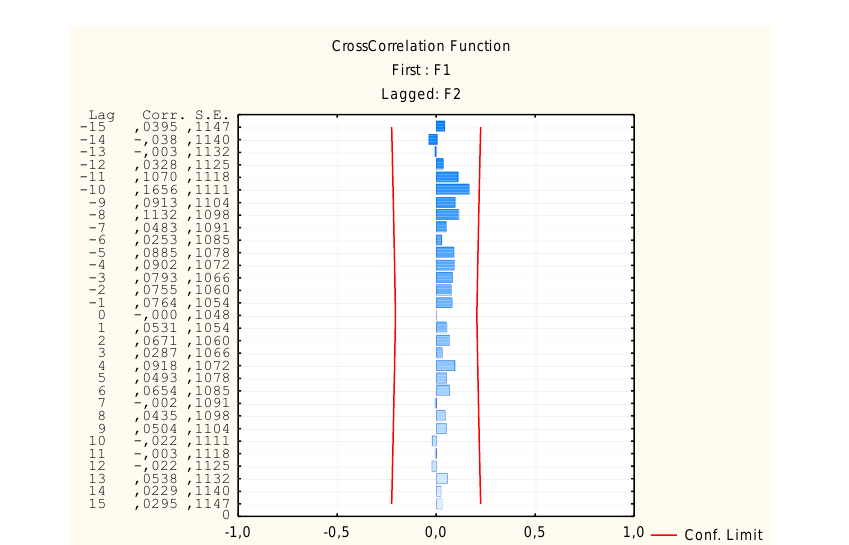
Fig. 13. Cross-correlation of main